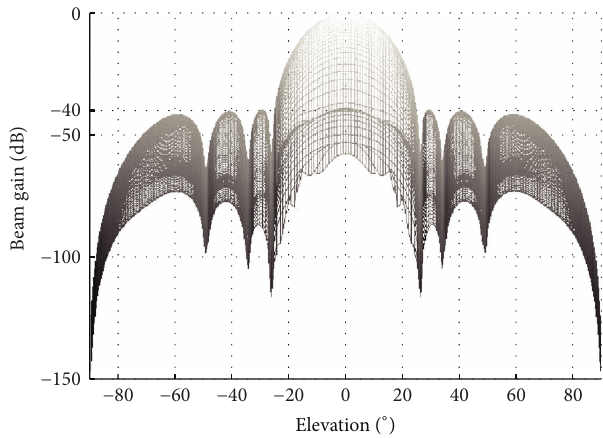
Figure 5: 2D beam pattern for the cylindrical array.